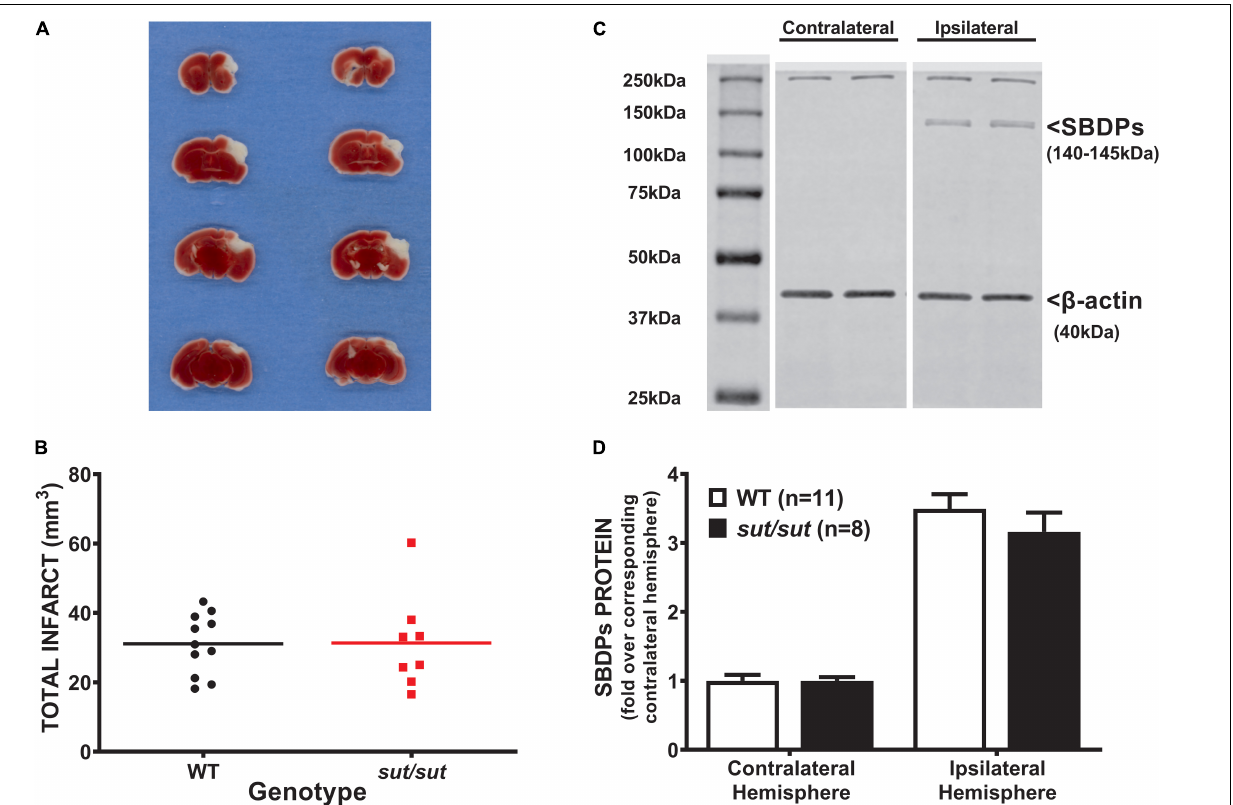
FIGURE 2 | Comparison of pMCAo-induced brain damage between system x c − null ( sut/sut ) mice and their wild type (WT) littermates. Forty-eight hr after pMCAo, brains were harvested from sut/sut ( n = 8) mice and their WT ( n = 11) littermates and cut in 1mm sections along the rostral-caudal axis. Sections 4, 6, 8, and 10 were used to quantify infarct volume, while the 5th, 7th and, 9th sections were used for immunoblot analysis of SBDPs, each as described in methods. (A) Representative TTC staining of coronal brain sections from WT (left panel) and sut/sut littermates (right panel). Lack of TTC staining delineates infarct. (B) Each data point (black dot: WT; red square: sut/sut ) represents total infarct volume in mm 3 from an individual mouse, whereas the horizontal line represents the mean of all mice. (C) Representative blot of SBDPs (D) SBDPs protein levels, normalized to their corresponding β -actin, are expressed as mean fold change + SEM over the corresponding contralateral hemisphere (set to